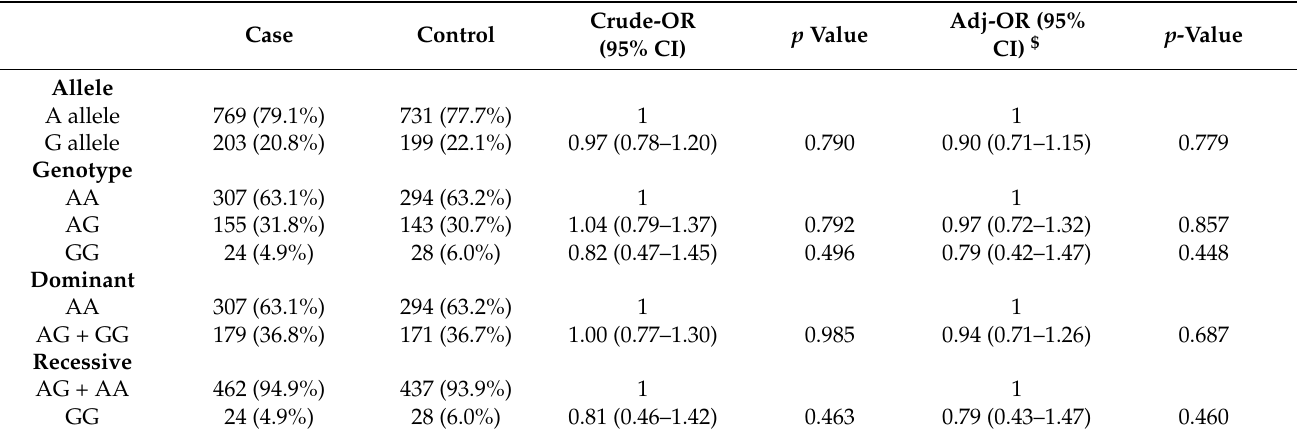
Table 2. The association between ESR1 XbaI and knee OA in case–control study.